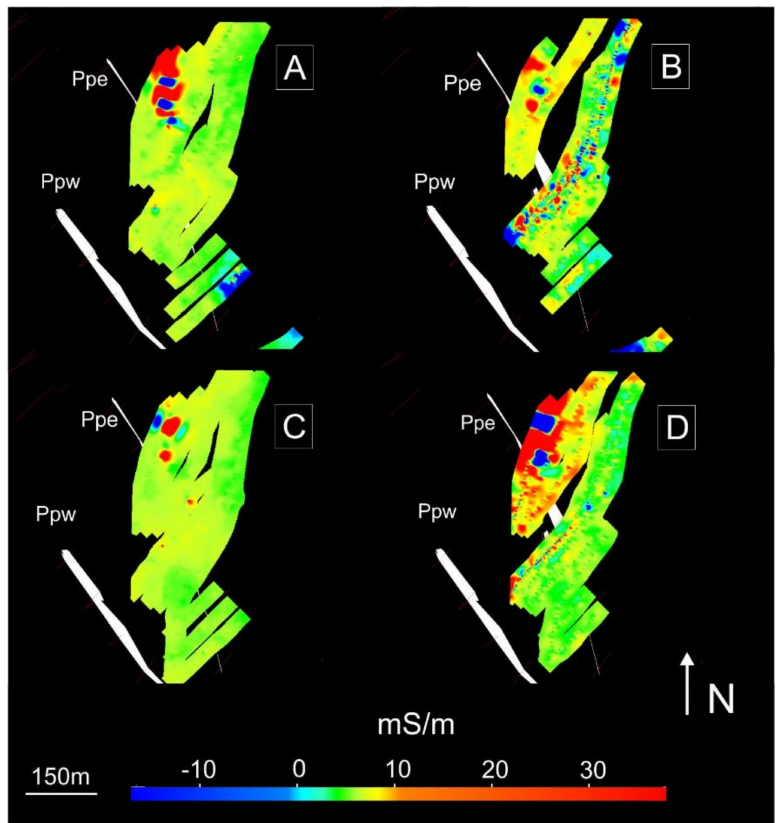
Figure 8. Electromagnetic results on the Poppelsberg East lode. ( A ) 20 m coaxial, ( B ) 40 m coaxial, ( C ) 20 m coplanar, and ( D ) 40 m coplanar. Ppe—Poppelsberg East lode; Ppw—Poppelsberg West